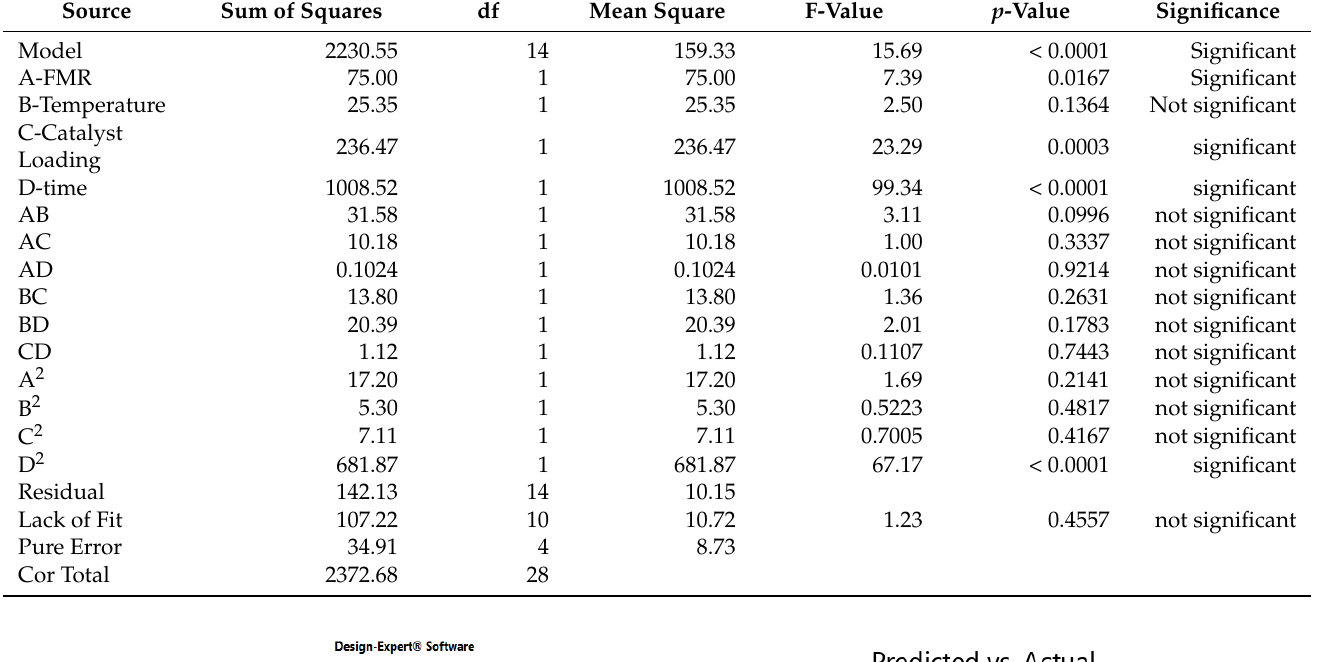
Table 3. Analysis of variance for response surface developed model.